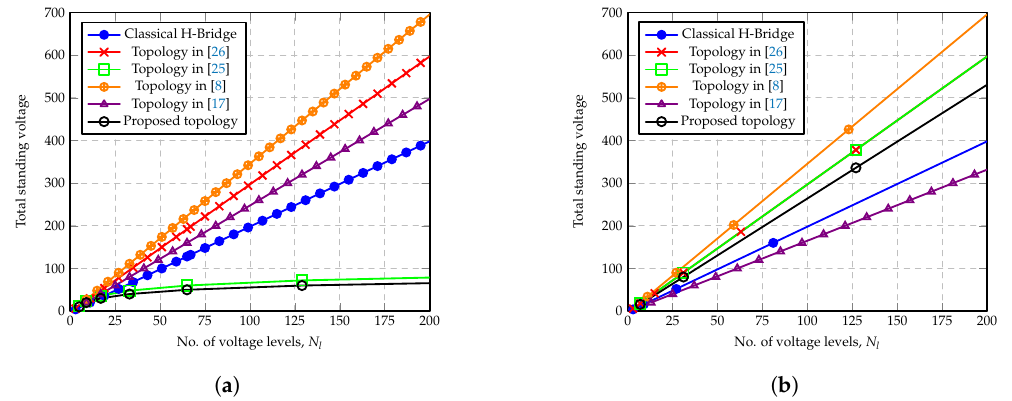
Figure 7. Total standing voltage vs. output voltage levels of the proposed inverter compared to the other three topologies in ( a ) symmetric mode and ( b ) asymmetric mode.